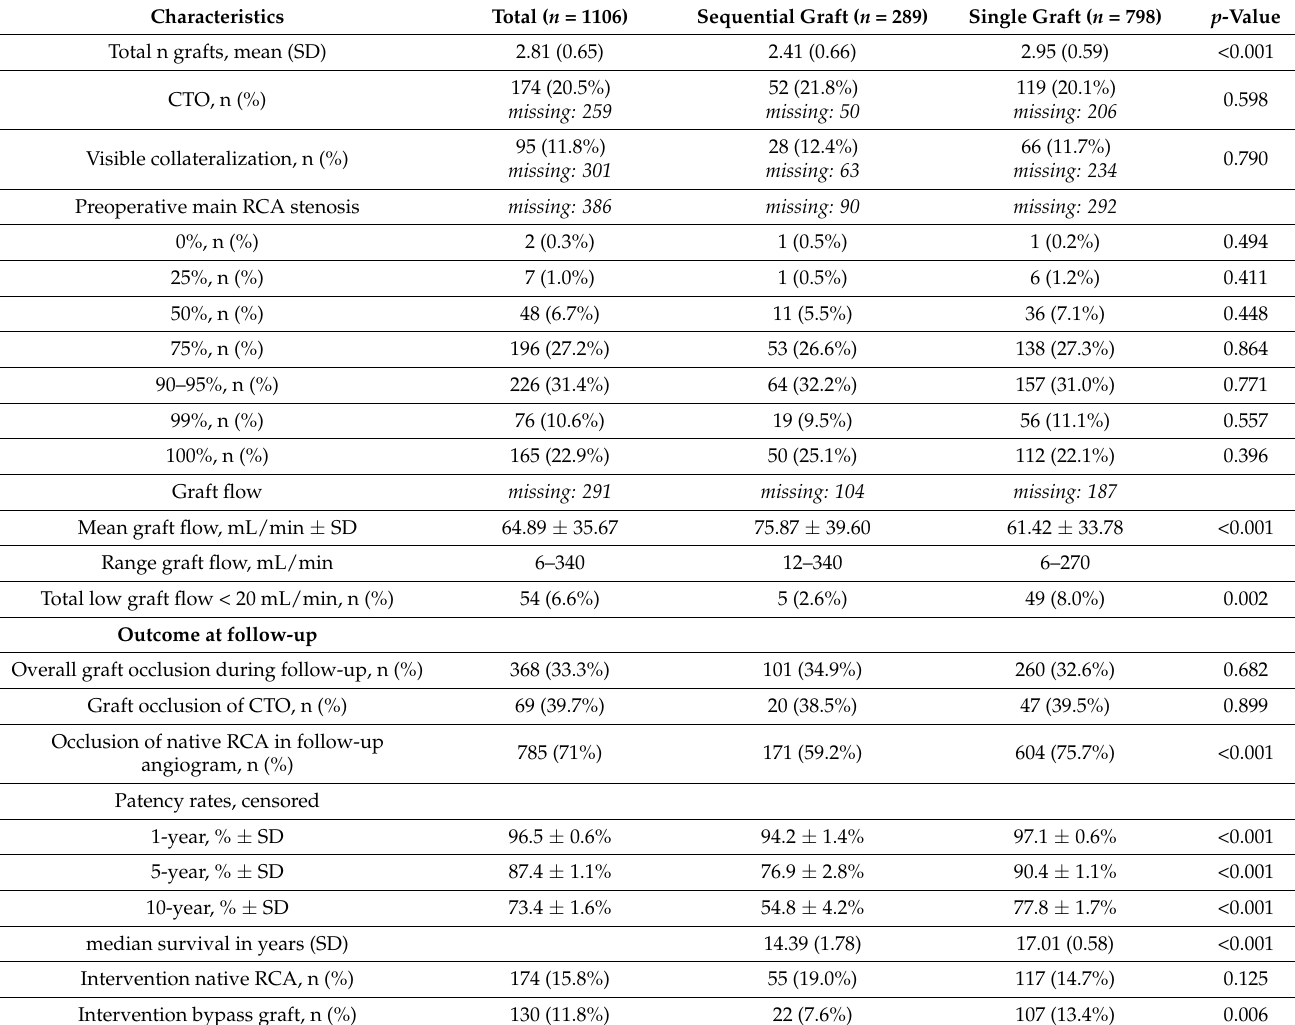
Table 2. RCA, perioperative and follow-up